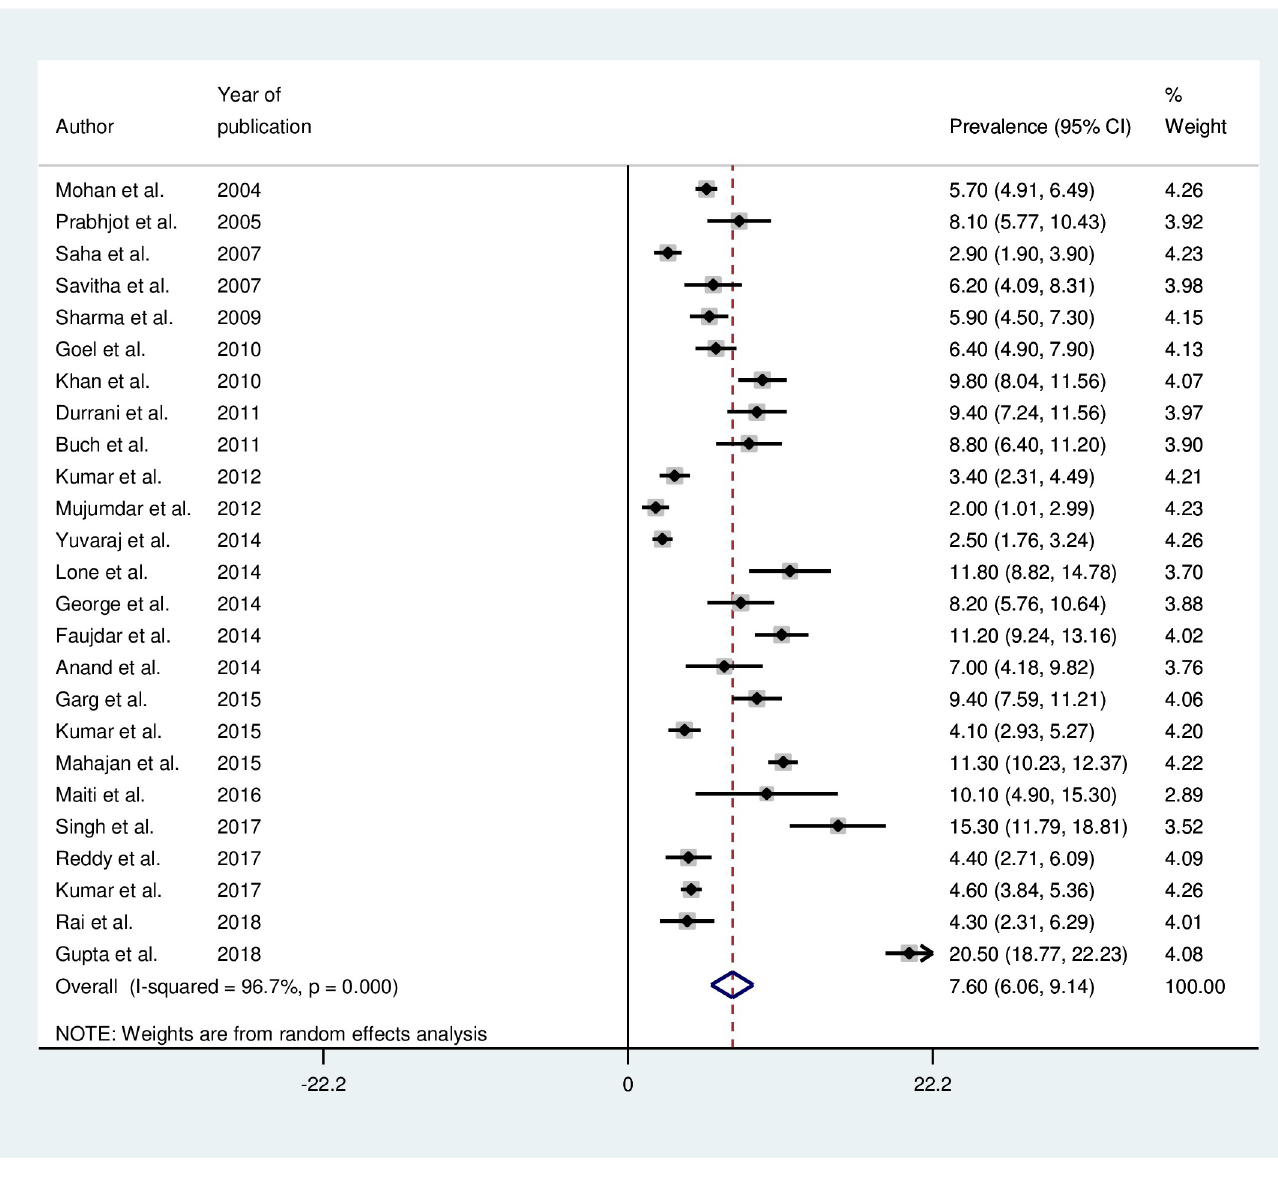
Fig 2. Forest plot of pooled prevalence of hypertension among adolescents in